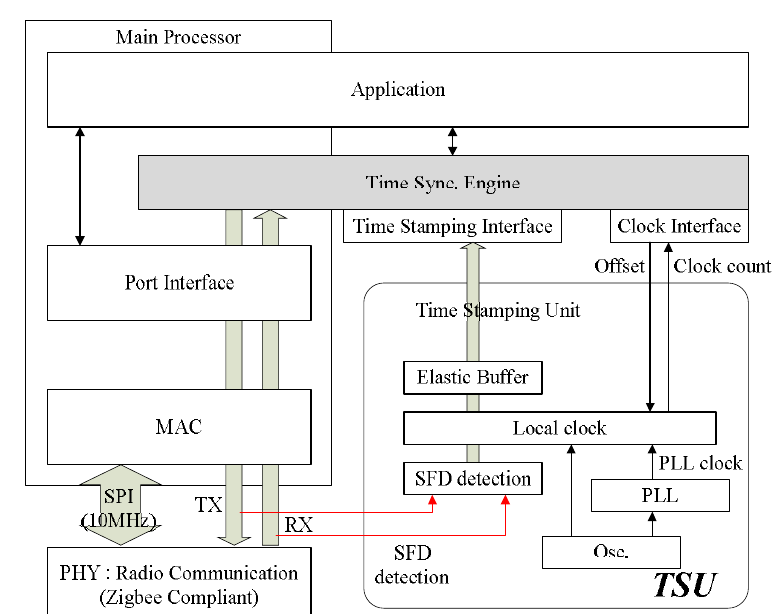
Figure 13. Precision time stamping